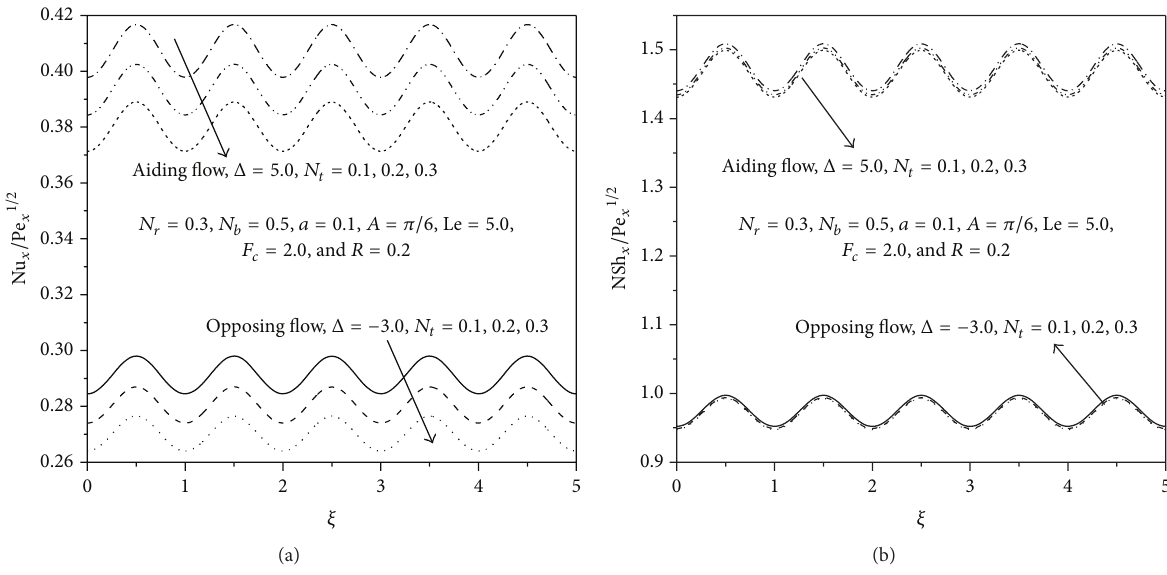
Figure 9: Effect of the themophoresis parameter ( 𝑁 𝑡 ) on the heat and nanoparticle mass transfer rates.